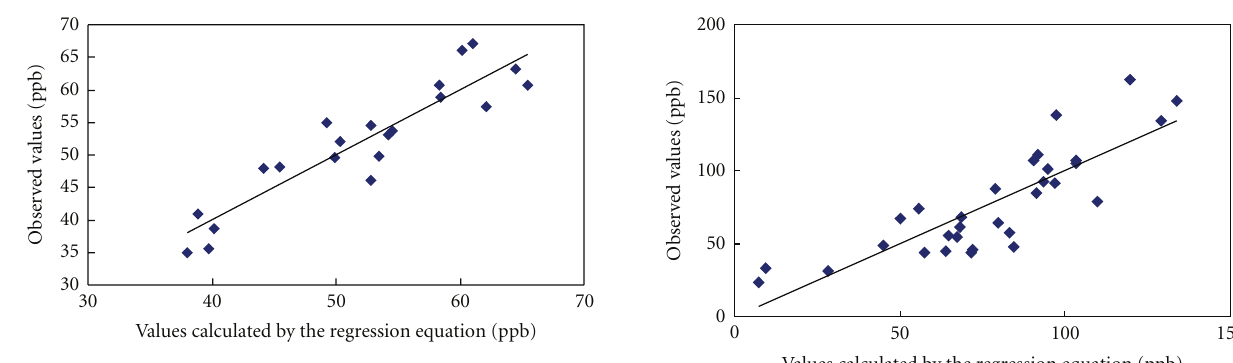
Figure 6: The observed seasonally averaged daily maximum O 3 concentrations for summer in the Tokyo area plotted against those Figure 7: The observed daily maximum O 3 concentration for predicted by the regression equation. August 2005 in the Tokyo area plotted against those predicted by the regression Table 4: The observed and predicted (by the statistical regression equation) seasonally averaged daily maximum O 3 concentrations in the Tokyo area. Statistical Periods Observation regression equation